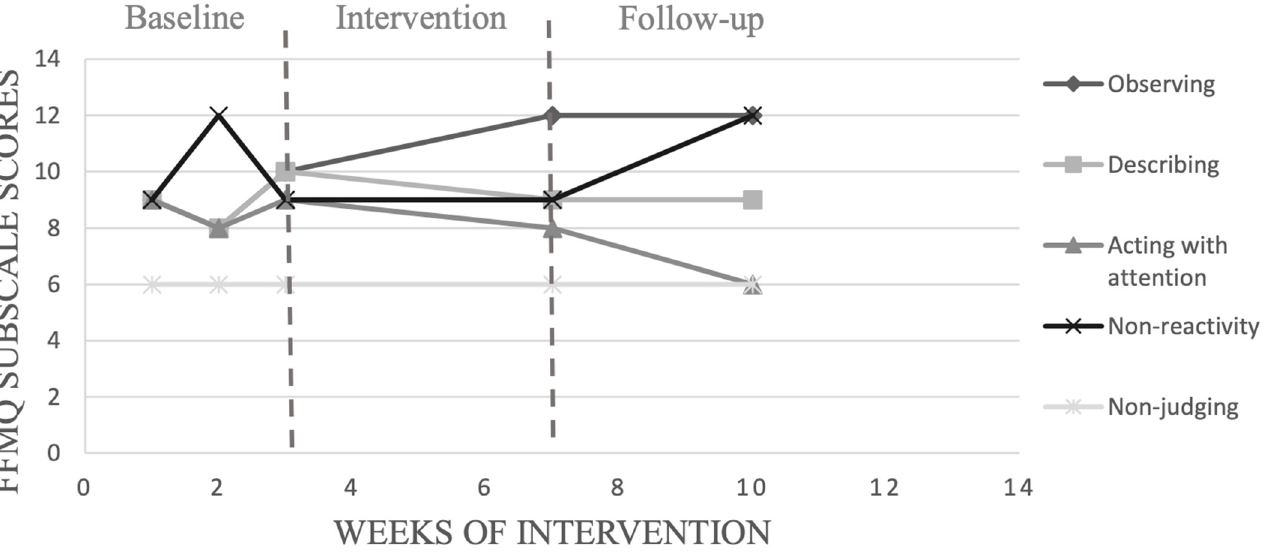
Figure 3. Evolution of scores obtained on the FFMQ with participant 1, across the weeks of inter- ventions.